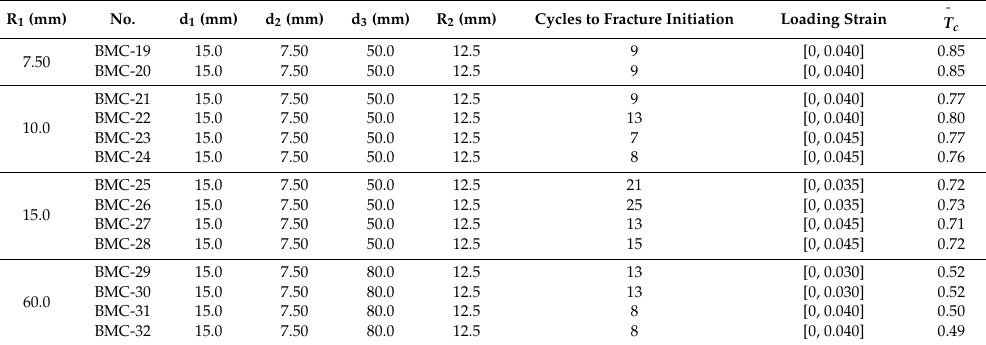
Table 5. Dimensions and experimental results of circular notched specimens.